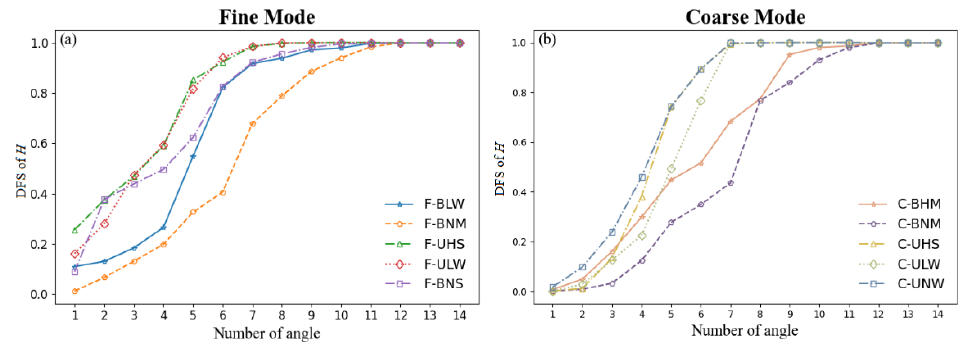
Figure 8. The DFS of H as a function of number of viewing angles for different aerosol models with AOD = 0.6 for the two aerosol types. The scale height is defined as 2 km. ( a ) represents fine mode aerosol types and ( b ) represents coarse mode aerosol types.